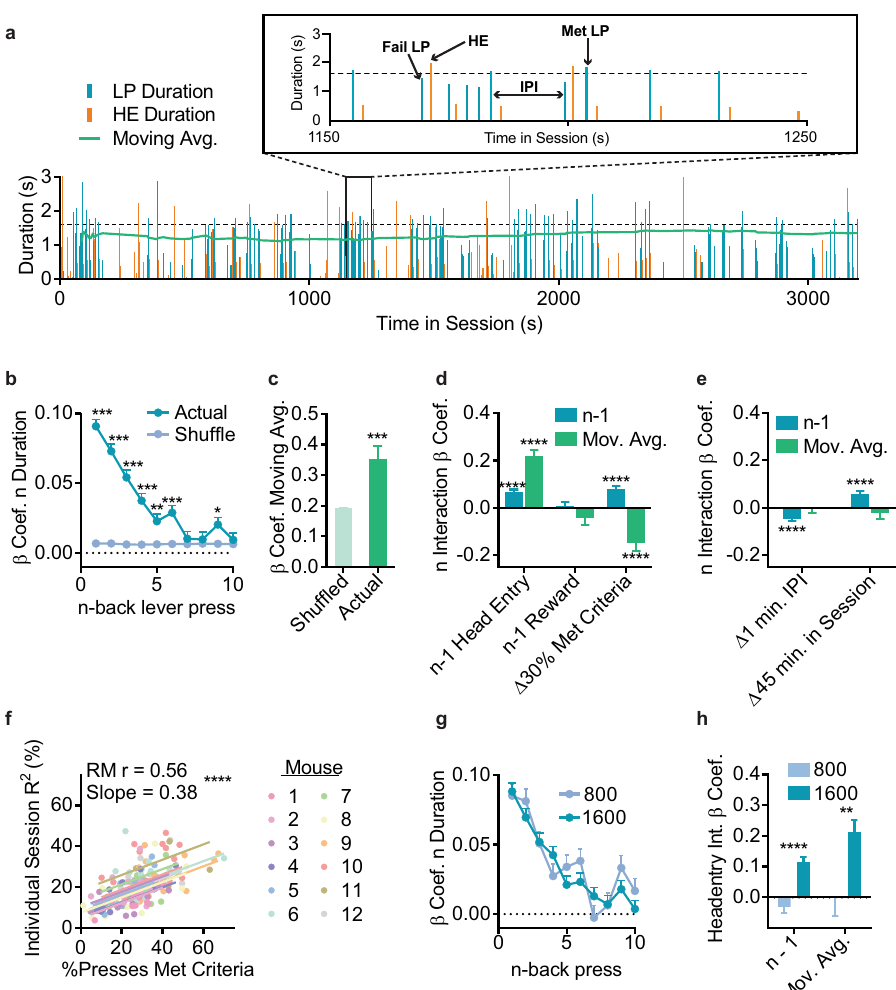
Fig. 2 Experience contributes to self-generated decision-making. a Sample data from one mouse (as in Fig. 1g, h) showing diversity of experiential information available. Top shows a zoomed in subset. Dashed line indicates 1600 ms criterion. b LME model β coef fi cients relating current lever press duration ( n ) to preceding press durations ( n - x) for Actual and order Shuf fl ed data. c Moving average β coef fi cient for Actual and Shuf fl ed data. d , e β coef fi cients for the interaction between experiential variables and recent ( n - 1 duration) or long-term (moving average) experience. For display purposes we transformed continuous variables to show relevant changes, e.g. time in session, which is in units of ms, was transformed to 45 min (half the duration of a session). f Repeated measures correlation between task performance (%Presses Met Criteria) and model fi t (R 2 ) for linear models built using individual session data. Intercept was allowed to vary across mice, while keeping a shared slope (Rm = 0.56, DF = 153, p < 0.0001, slope = 0.38). g As in b